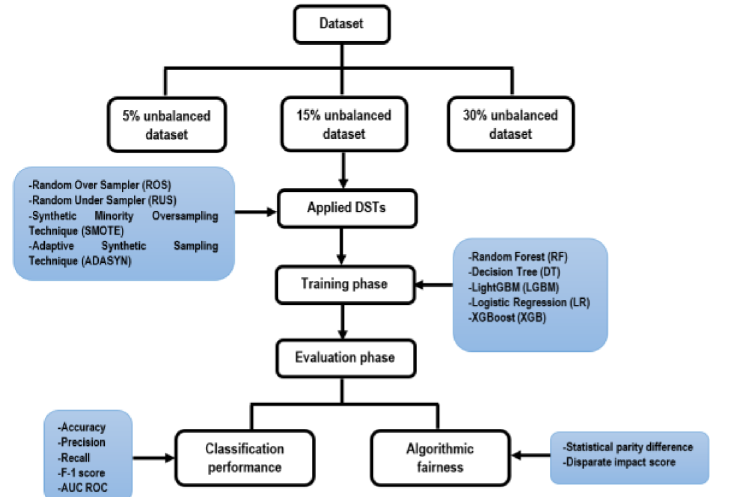
Figure 1. Procedures of the